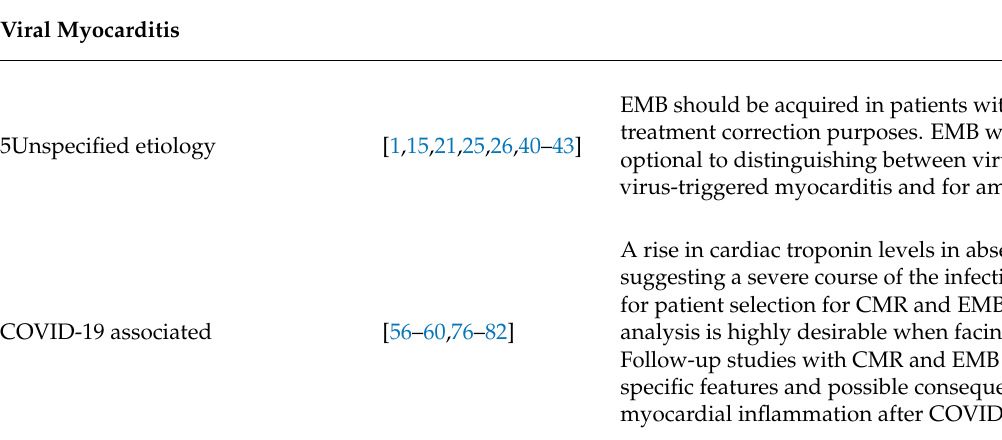
Table 5. Summary of literature-based findings in specific settings of